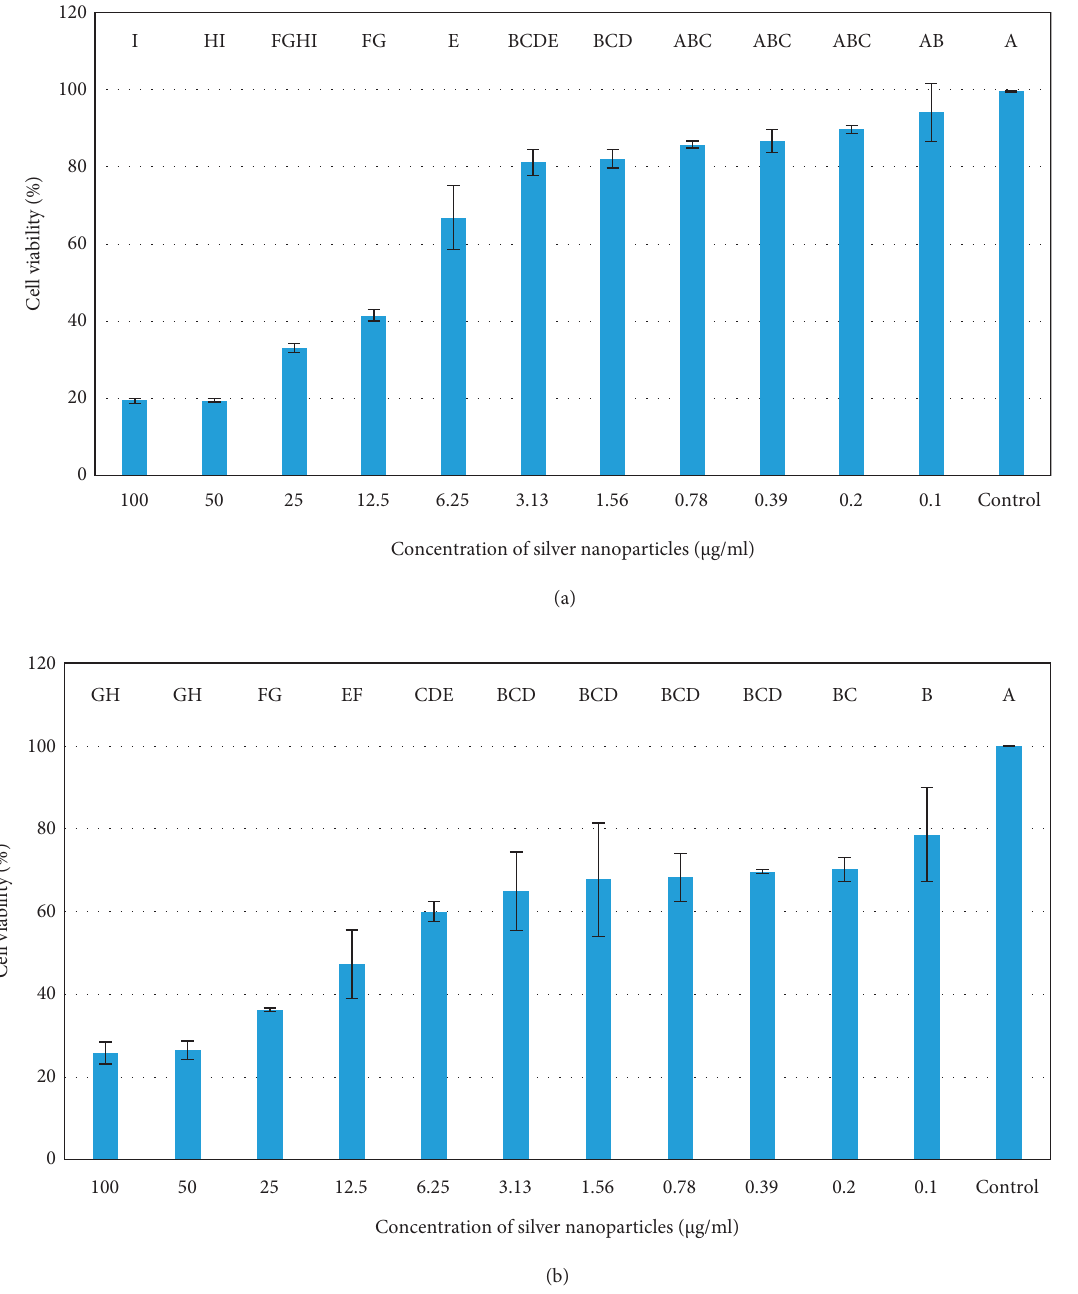
Figure 6: Cytotoxic effect on breast carcinoma cell line MCF-7 (a) and human hepatocellular carcinoma cell line HepG2 (b) treated with various concentrations of silver nanoparticles (from 0.1 to 100 μ g/ml) synthesized by extract of Cystoseira myrica compared to breast carcinoma cell line and HepG2 human hepatocellular carcinoma cell line free from any treatment (control) after 48hours of time exposure [different letters represent the significance between different groups and same letters express the nonsignificance between different